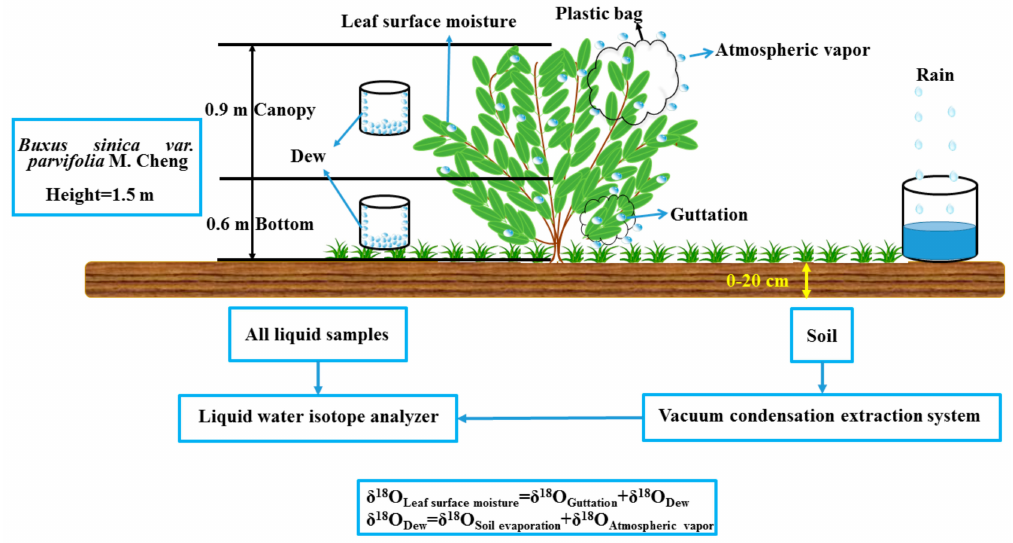
Figure 2. Schematic of sample collection and